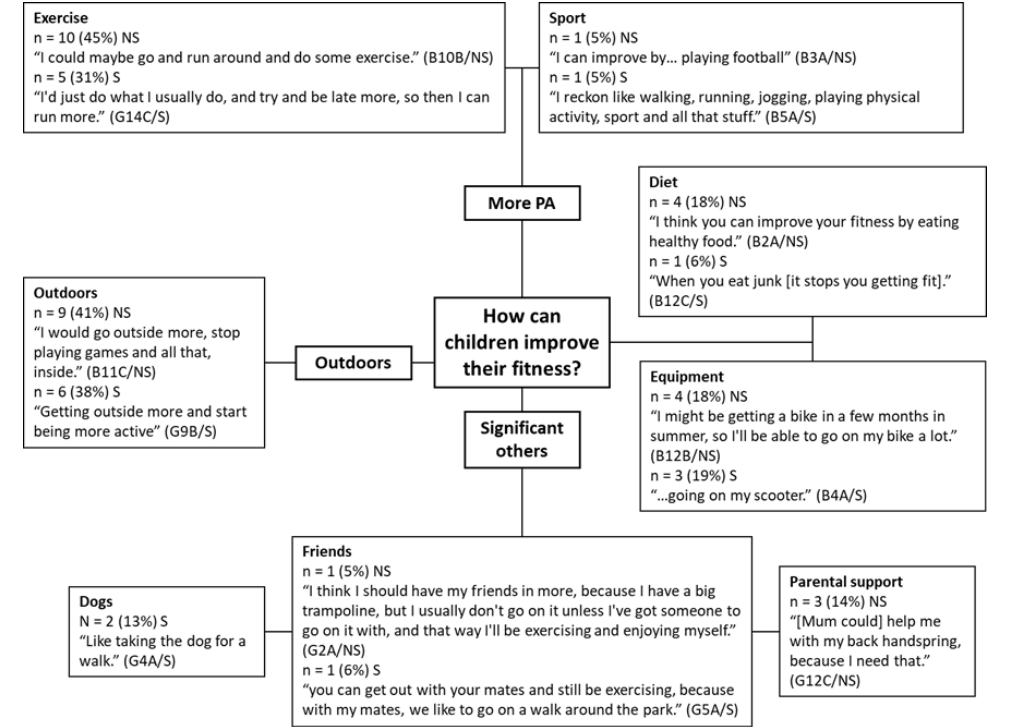
Figure 3. How can children improve their fitness according to children from smoking (S) and non-smoking (NS) homes. Percentages represent the proportion of each group that contributed to the theme for children from smoking ( n = 16) and non-smoking homes ( n = 22).